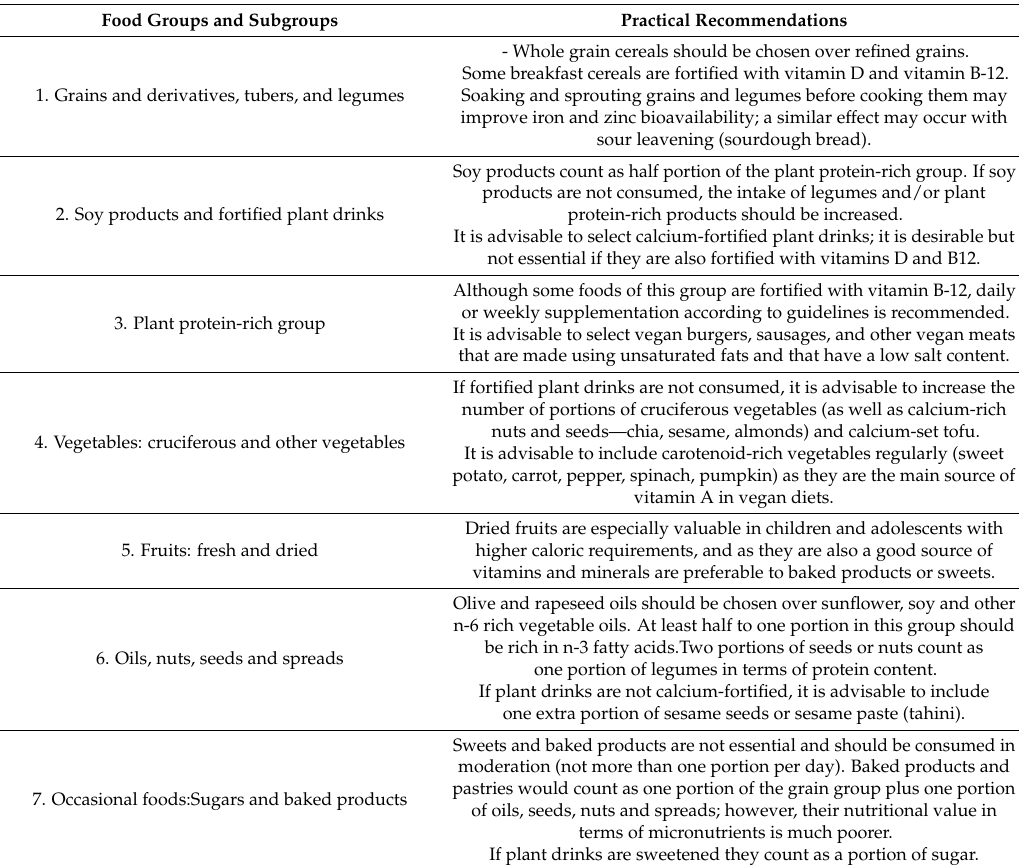
Table 3. Recommendations for food selection with food groups and